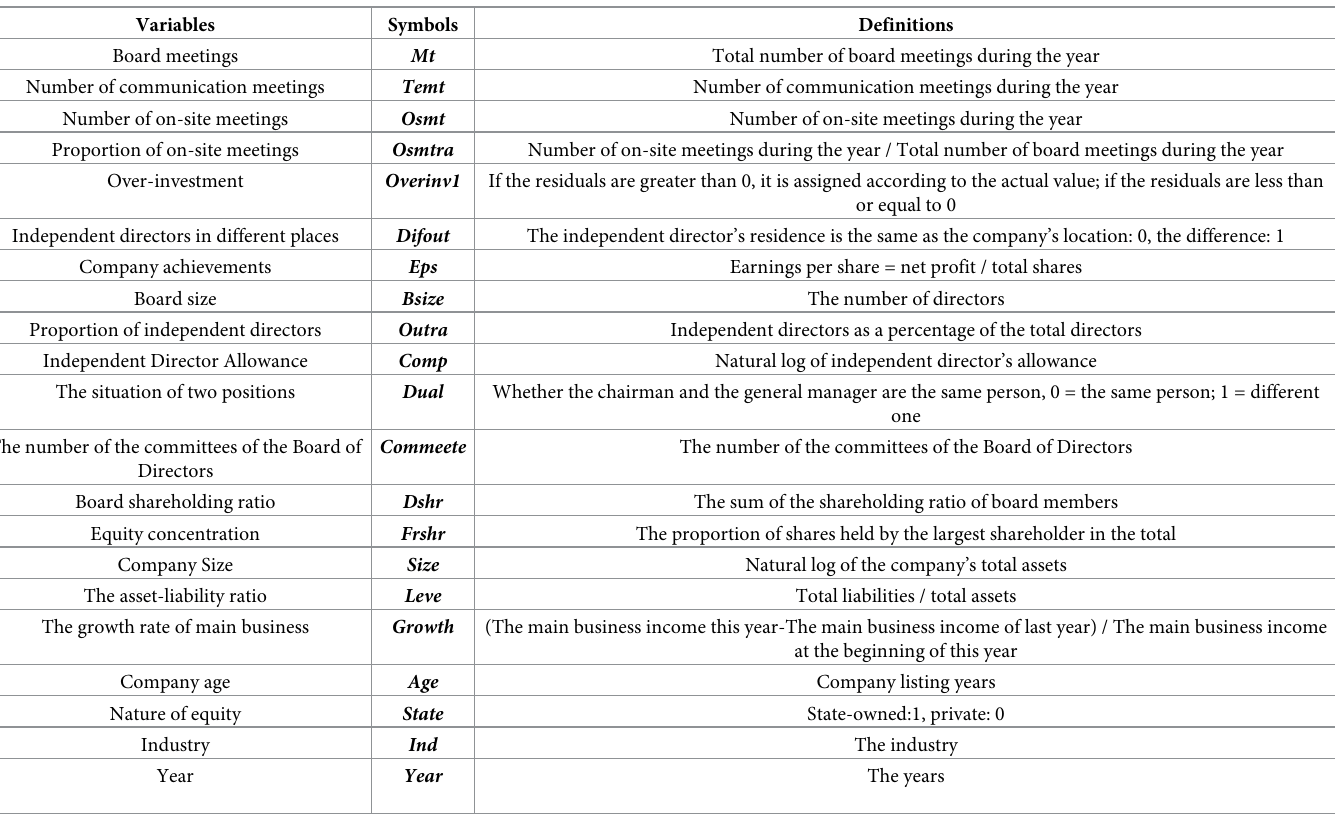
Table 1. Definitions of